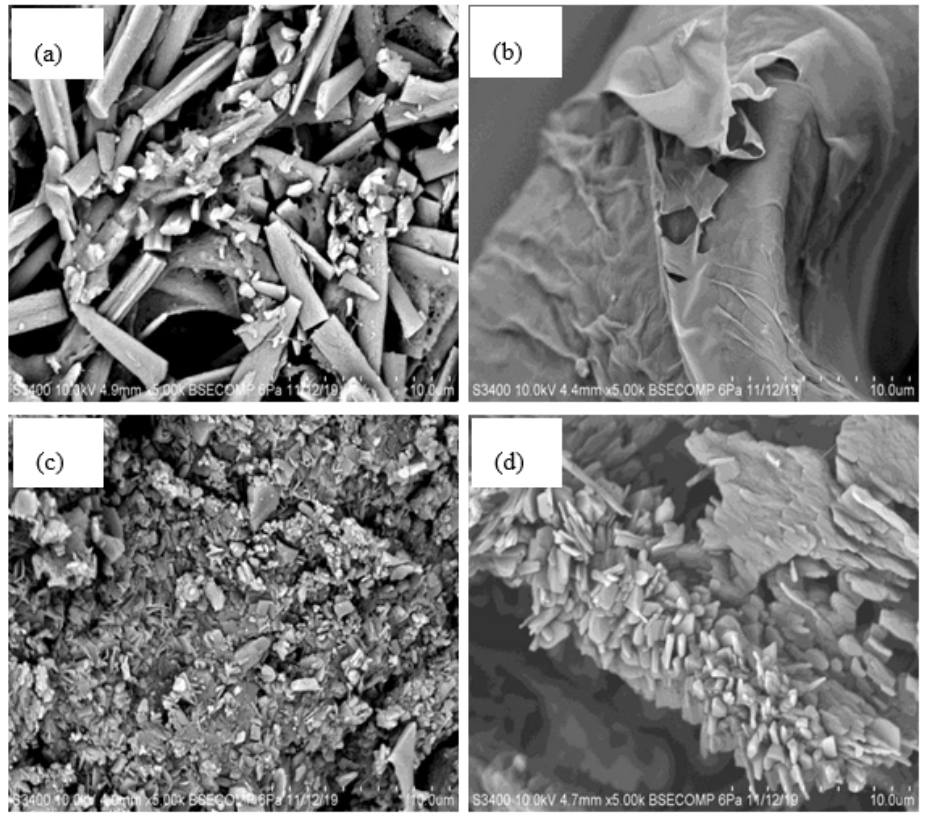
Fig. 2. Surface morphology of refined carrageenan with magnification 5000x (a) 1M KOH Oven,